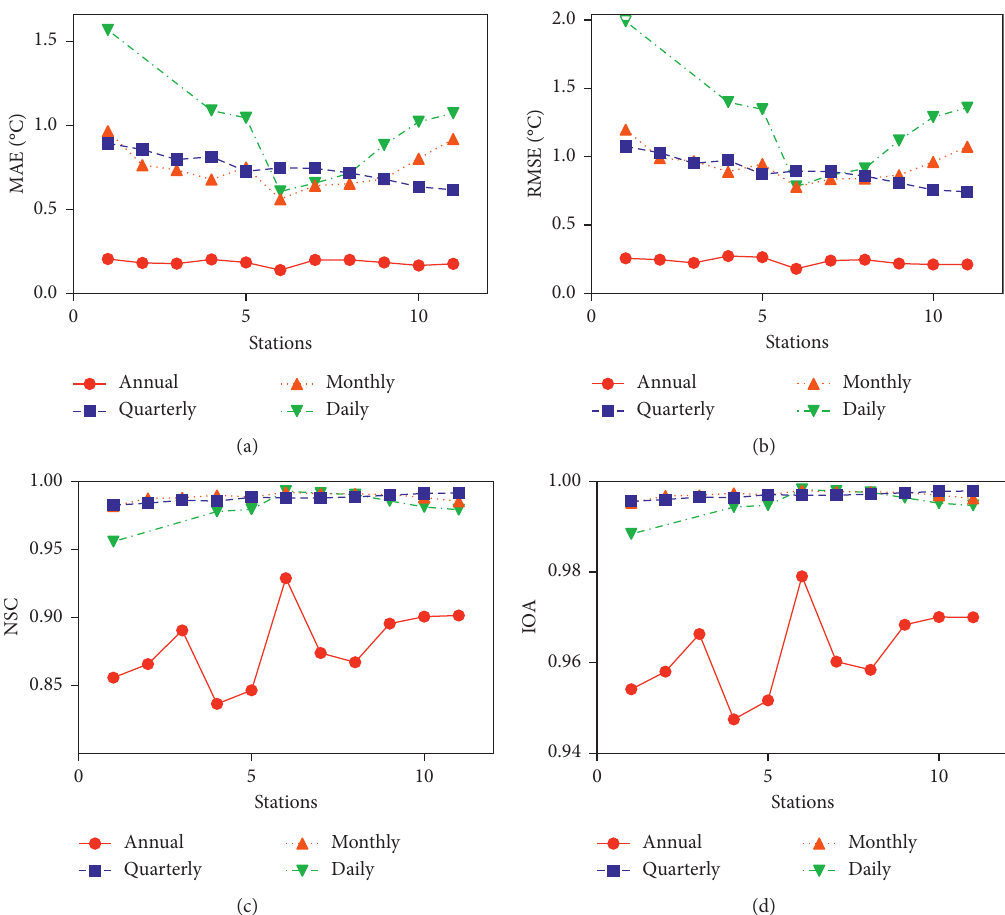
Figure 1: Comparison of single-station kernel regression indicators at multiple time scales: (a) MAE; (b) RMSE; (c) NSC; (d)